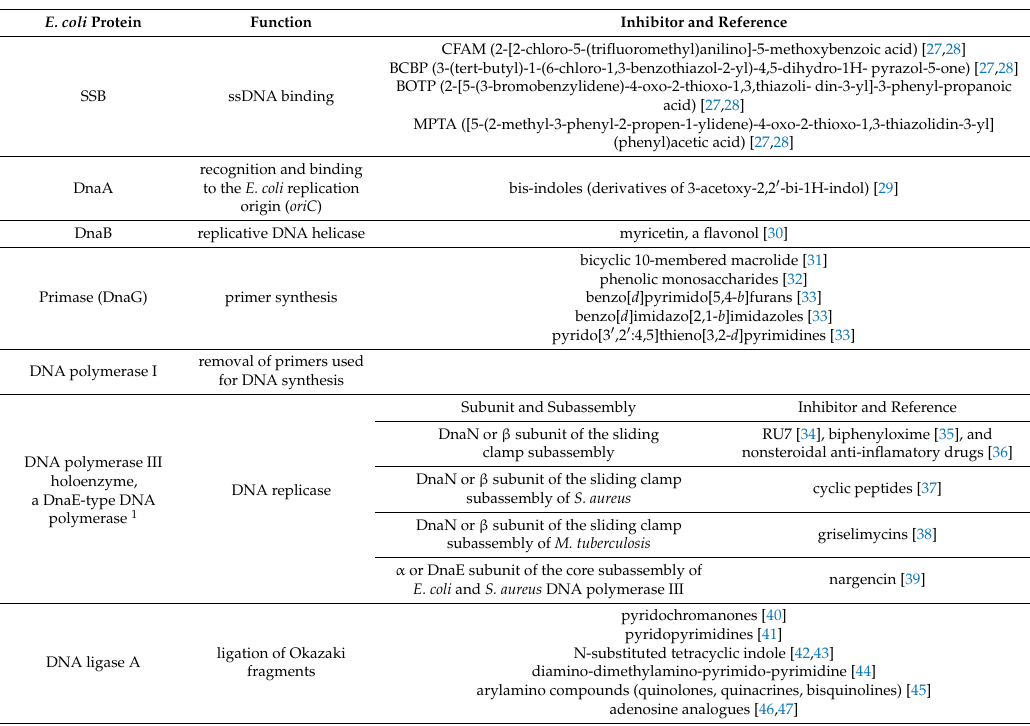
Table 1. DNA replication proteins and their